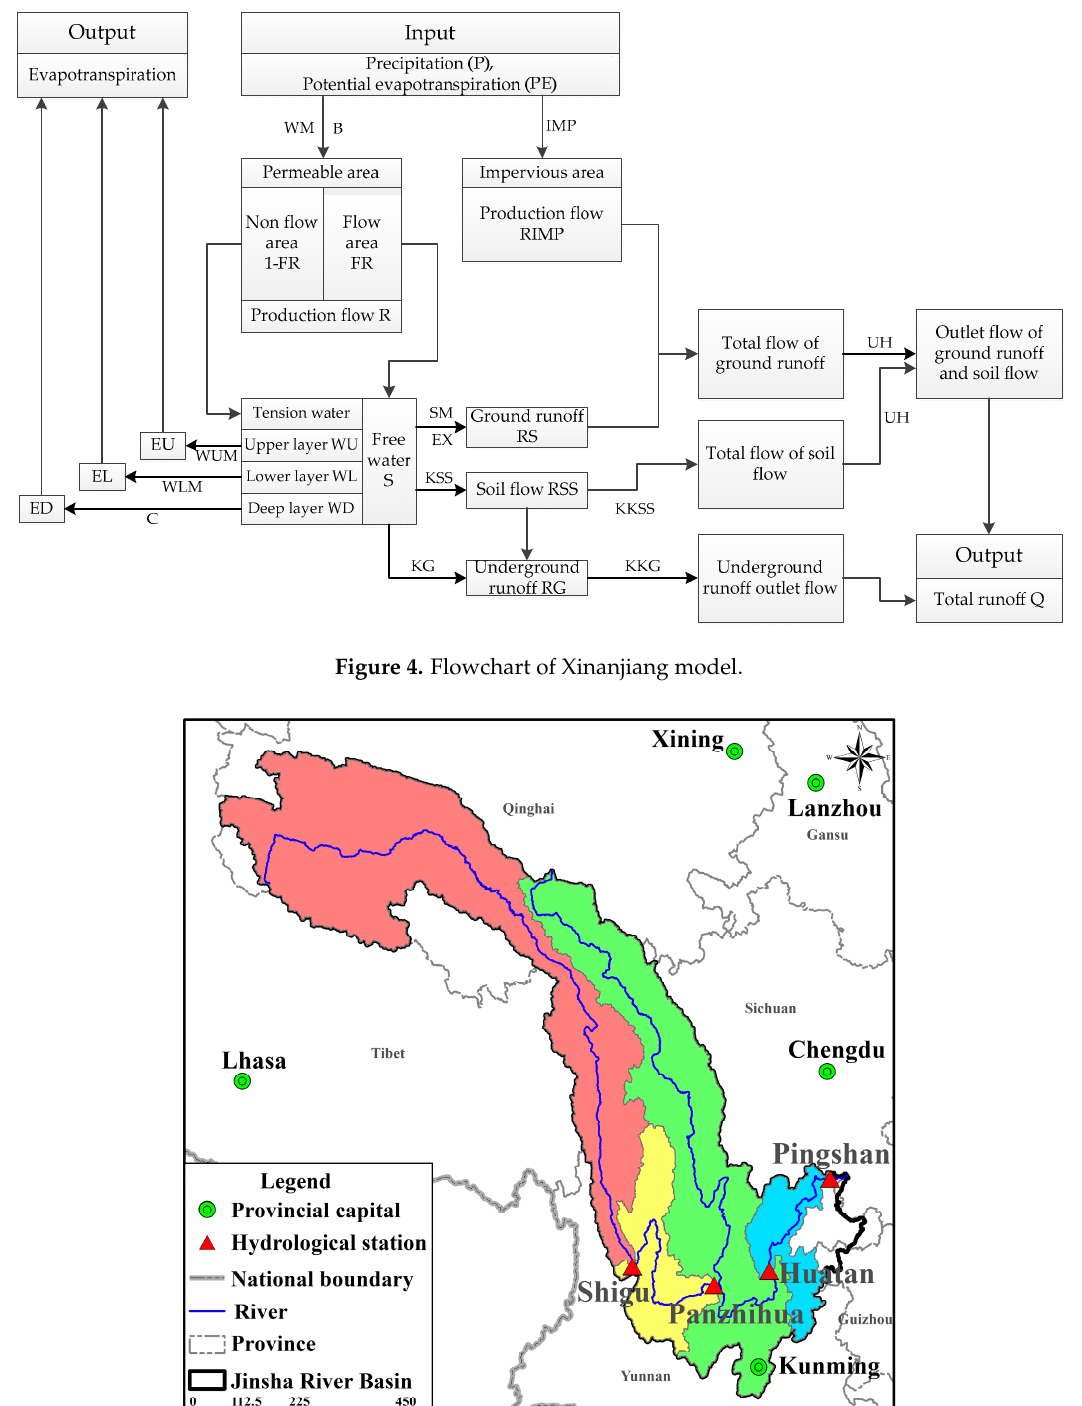
Figure 5. Sub-catchments in the Jinsha River.